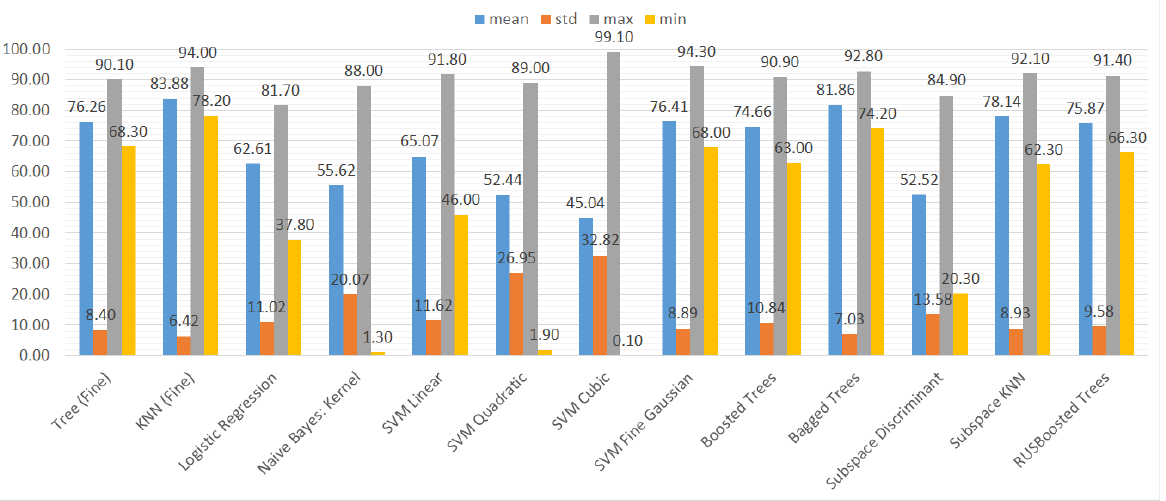
Figure 11. Mean, standard deviation, maximum, and minimum of the recall (TPR) results for different types of